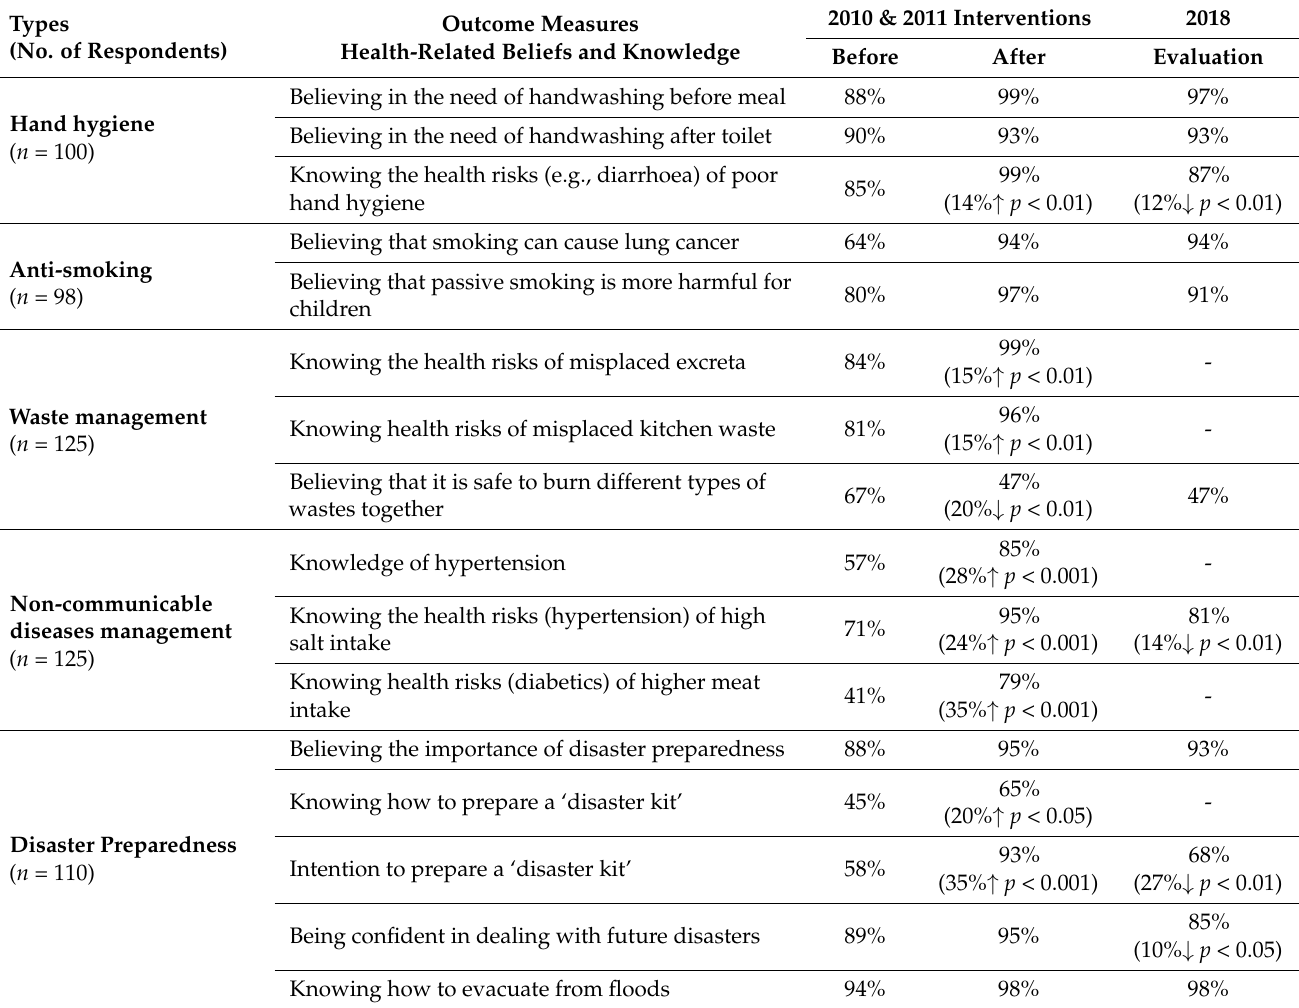
Table 3. Changes in beliefs and knowledge in the 2010/2011 pre- and post-intervention and the 2018 evaluation